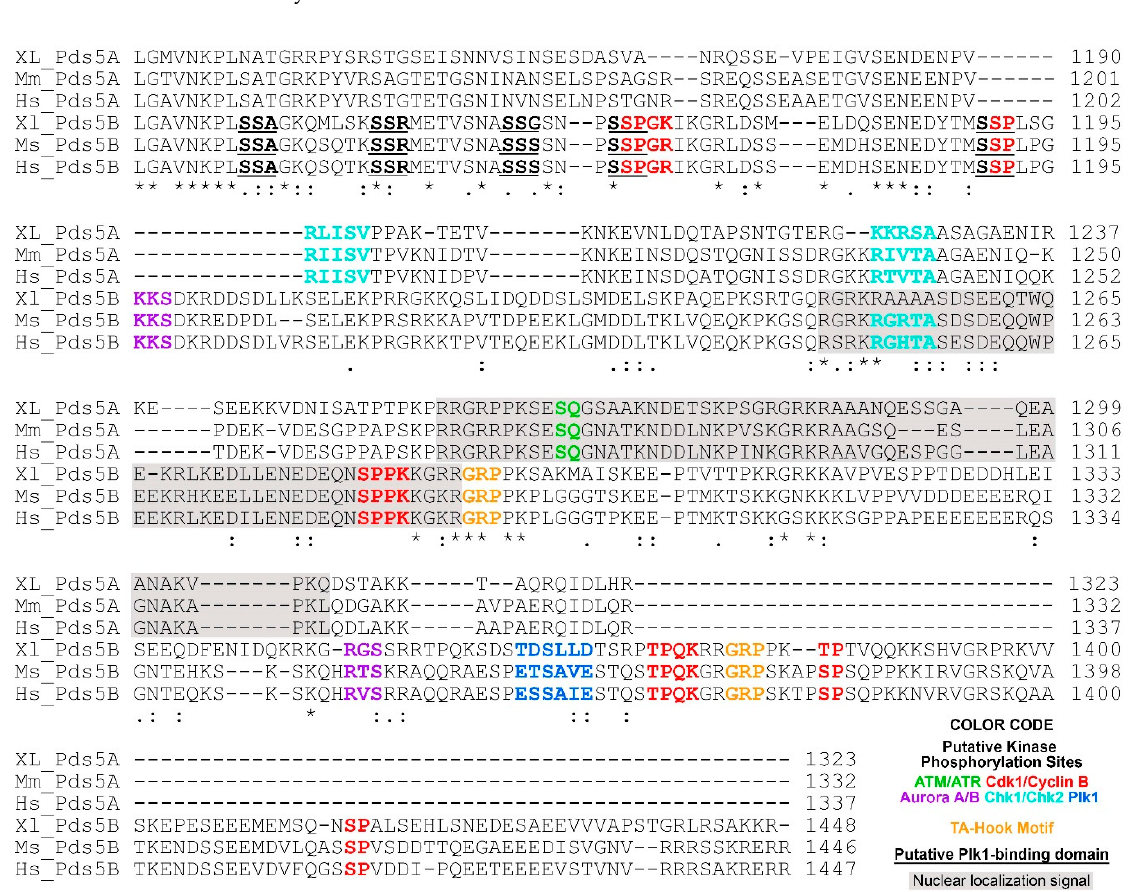
Figure 2. C-terminal alignment of PDS5A and PDS5B from frog ( Xenopus ), mouse and human. The following putative regulatory features are highlighted in color: ATM/ATR phosphorylation motif (S/T)-Q [62]; Aurora A/B phosphorylation motif (R/K) 1-3 -X-(S/T)-(^P) where X is any amino acid, and ^P is not proline [63–65]; Cdk1/Cyclin B phosphorylation motif minimum consensus sequence (S/T)-P, full consensus sequence (S/T)-P-X-(K/R) [66]; Chk1/Chk2 phosphorylation motif ( Φ /B)-(X/B)-(R/K)-X-X-(S/T)- Φ where B is a basic amino acid and Φ is a hydrophobic amino acid [67]; Plk1 phosphorylation motif (D/E)-X-(S/T)- Φ -X-(D/E). Plk1 binding domain (PBD) S-(pS/pT)-(P/X) where pS is a phosphorylated serine, pT is a phosphorylated threonine [68]. PBD is underlined. AT-hook motif GRP is highlighted in orange [69]. Nuclear localization signals are predicated using cNLS Mapper [70] and shaded in gray. The alignment was performed using Clustal O (1.2.4) [71]. Invariant, conserved and semi-conserved residues are indicated by an asterisk (*), colon (:) and period (.), respectively. The abbreviations are XL, Xenopus laevis ; Mm, Mus musculus ; Hs, Homo sapiens . Protein sequences are from NCBI and the access reference numbers are NP_001090063.1 (XL-PDS5A); NP_001089658.1 (XL-PDS5B), NP_001074790.1 (Mm-PDS5A), NP_780519.3 (Mm-PDS5B), NP_001093869.1 (Hs-PDS5A), NP_055847.1 (Hs-PDS5B).